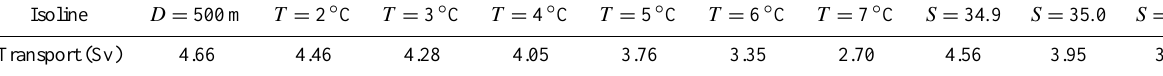
Table 2. Average (1 January 1993–1 May 2014) volume transport between N02 and A 8 above either a fixed depth of 500m, a selected average isotherm ( T = ), or a selected average isohaline ( S = ) in the hydrographic fields.